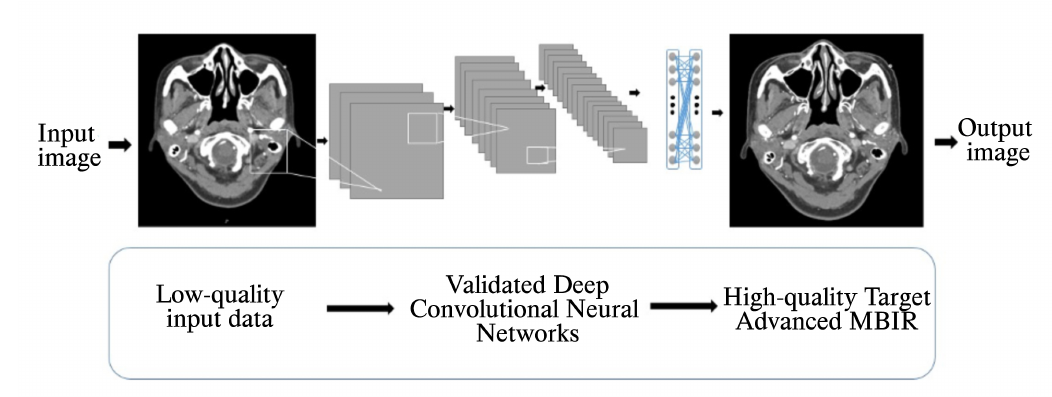
Fig.1. Overviewofdeeplearningreconstruction. Thevastlearningcapacitiesofthedeepconvolutionalneuralnetworkallowfordifferentiationbetween the signal and the noise. Consequently, deep learning reconstruction (DLR) reduces artifacts and noise separately from the signal. AiCE, a DLR used in this study, was trained to use advanced model-based iterative reconstruction (MBIR) target